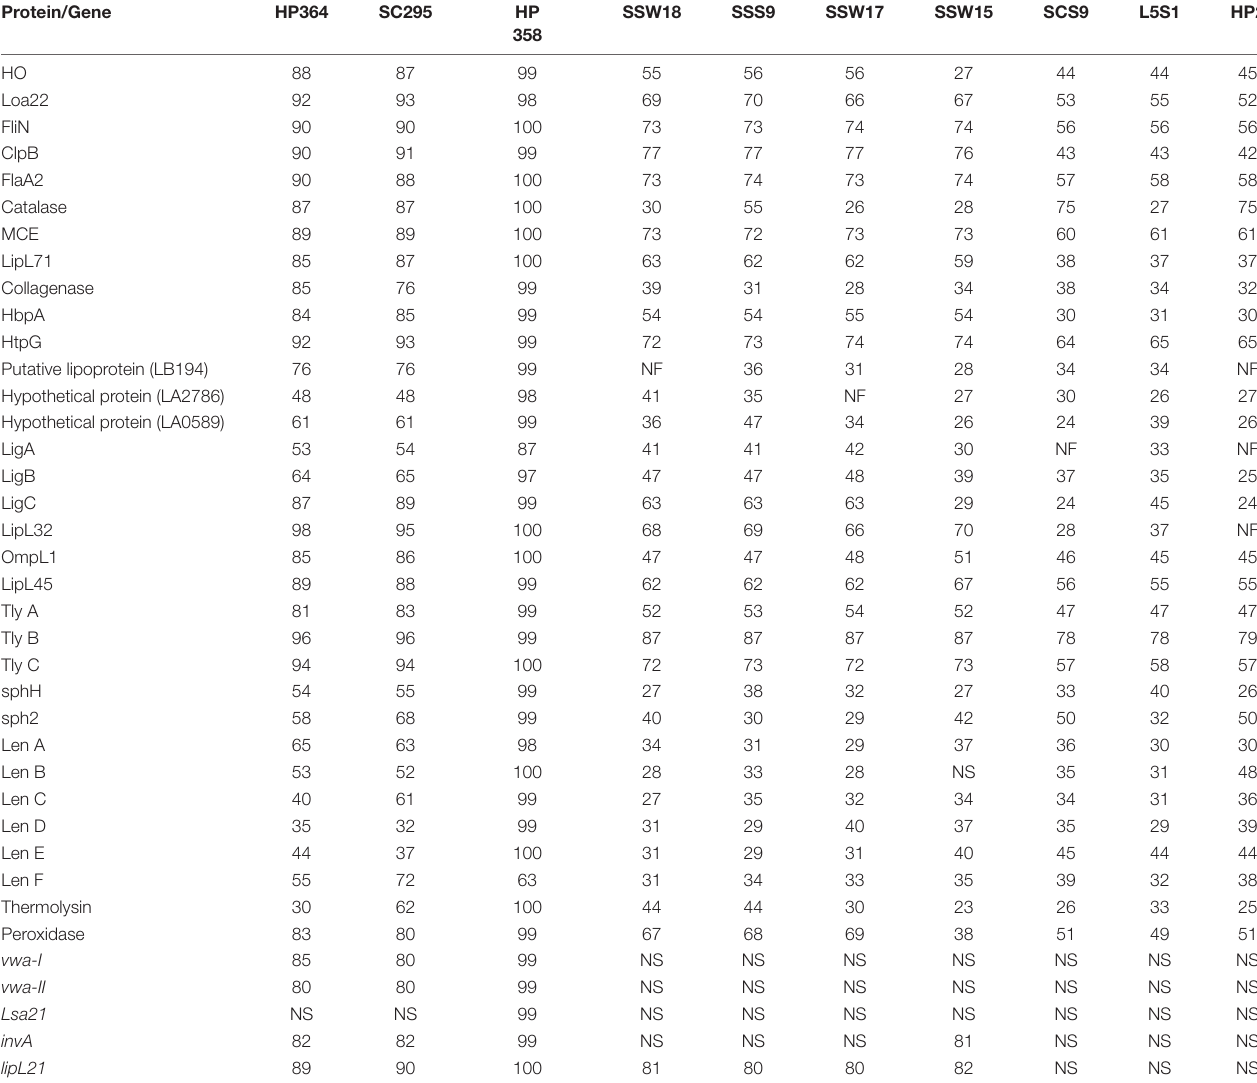
TABLE 5 | The presence/absence and percentage of homology of the known virulence factors in each tested strain.